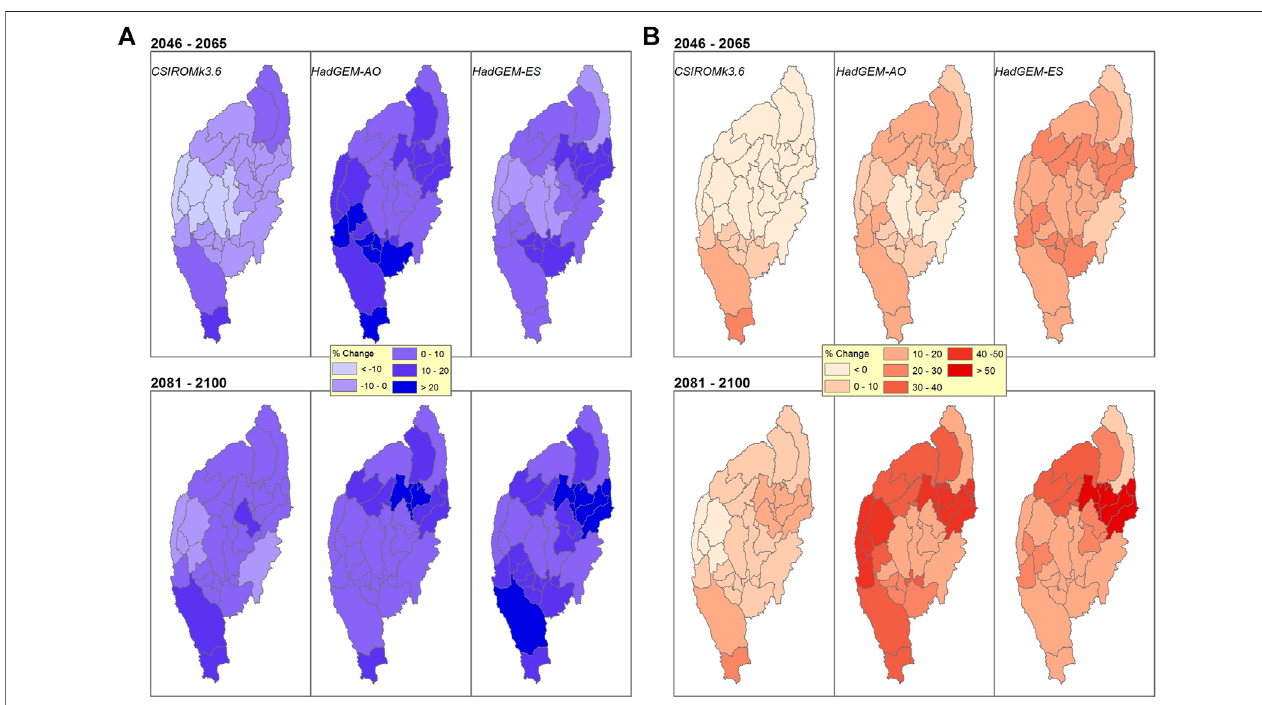
FIGURE 4 | Percentage change of precipitation under two RCPs (RCP 2.6 (A) and RCP 8.5 (B) ) of the three selected GCMs (from left to right CSIRO Mk3.6, HadGEM2-AO, andHadGEM2-ES), relative tothebaseline period (1991 – 2005)over each sub-basin oftheIrrawaddyRiverBasin.Ineach RCPplot, twofuture periods are presented: 2046-2065 (top) and 2081-2100 (bottom)